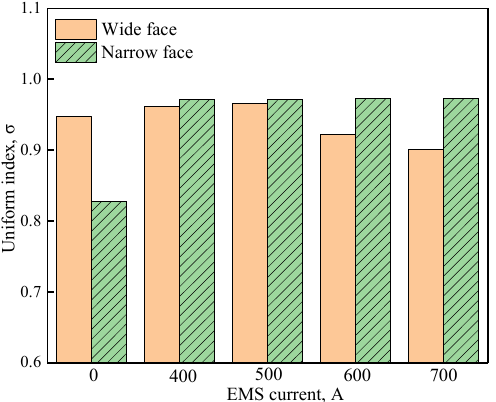
Figure 9. Uniform index at z = − 0.4 m under different EMS currents.